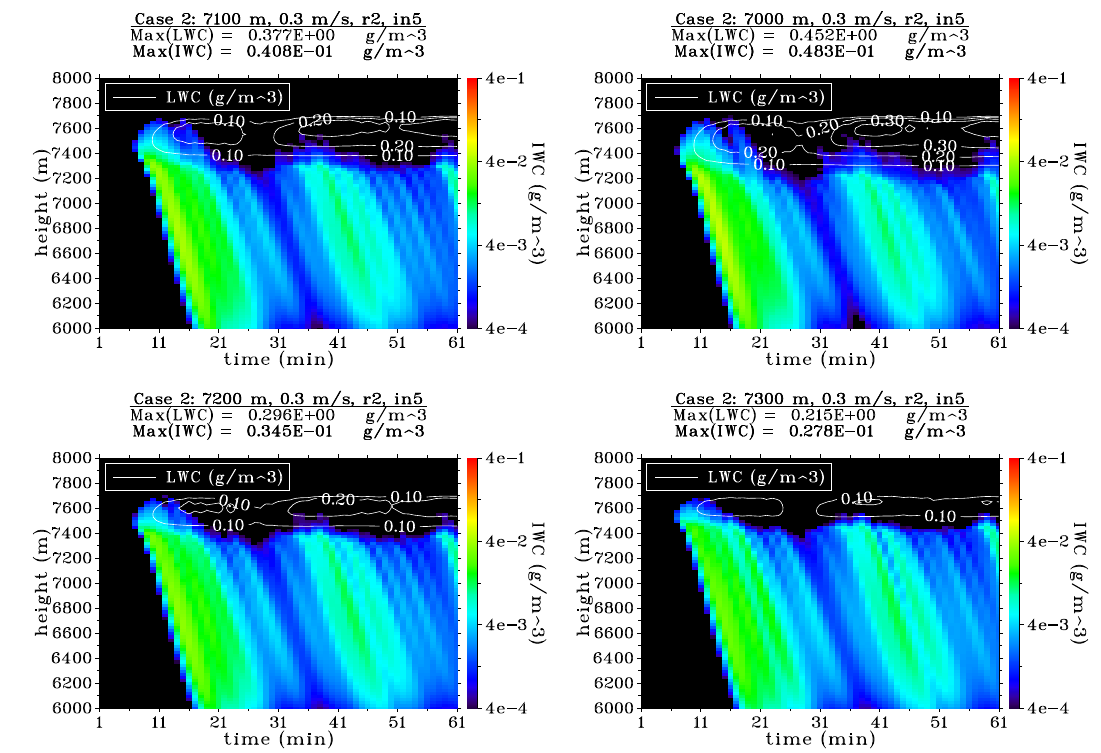
Figure 13. LWC (contours) and IWC (colors, logarithmic scale) for case 2. Comparison of different values for h bot (upper left: C_base, h bot = 7100m; upper right: C_h70, h bot = 7000m; lower left: C_h72, h bot = 7200m; lower right: C_h73, h bot = 7300m).